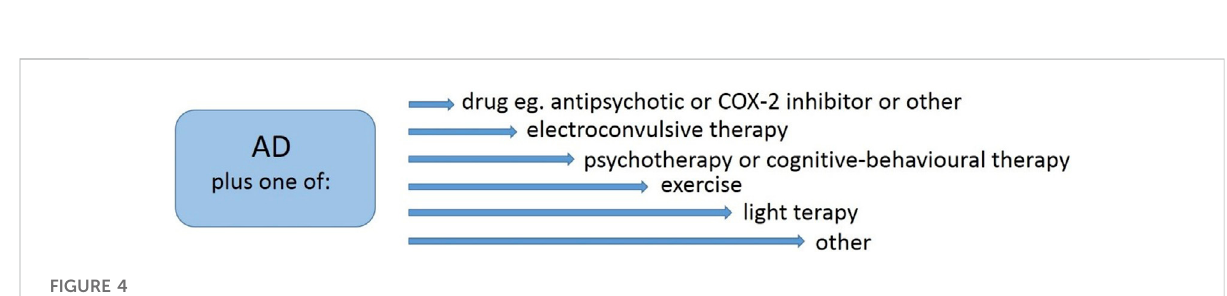
FIGURE 4 Examples of combined therapy in the treatment of depression. AD, antidepressant; COX-2, cyclooxygenase